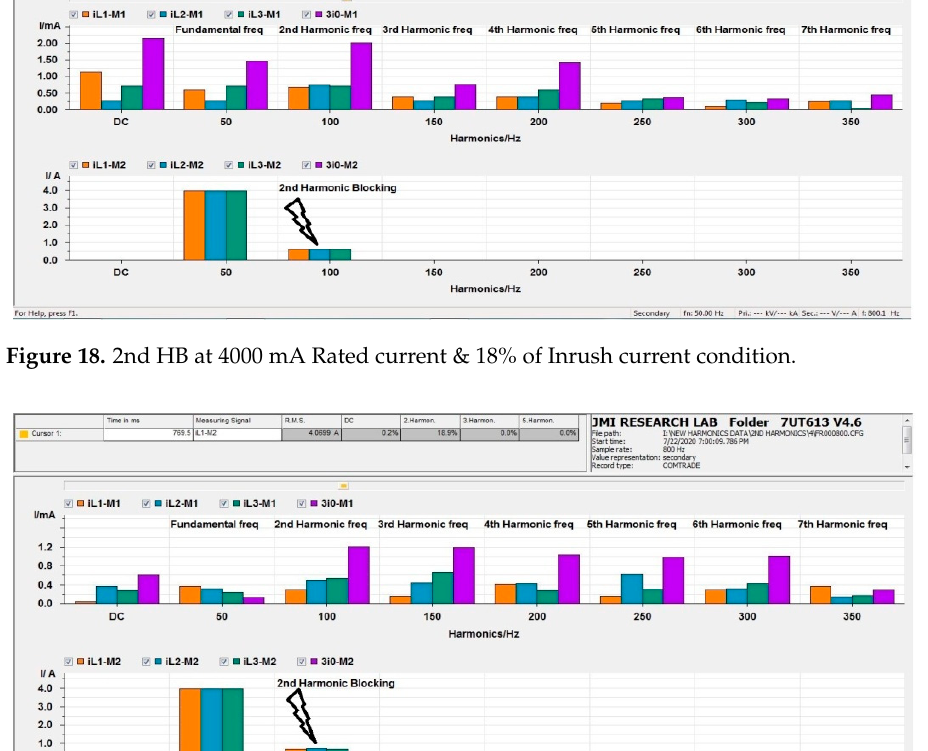
Figure 19. 2nd HB at 4000 mA Rated current & 20% of Inrush current condition.